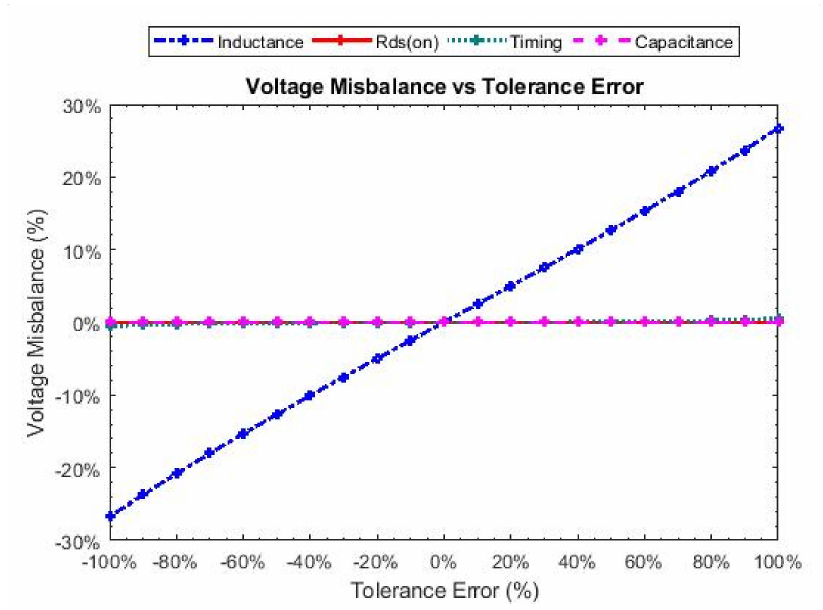
Figure 6. DVFW voltage balance vs. primary inductance tolerances at high